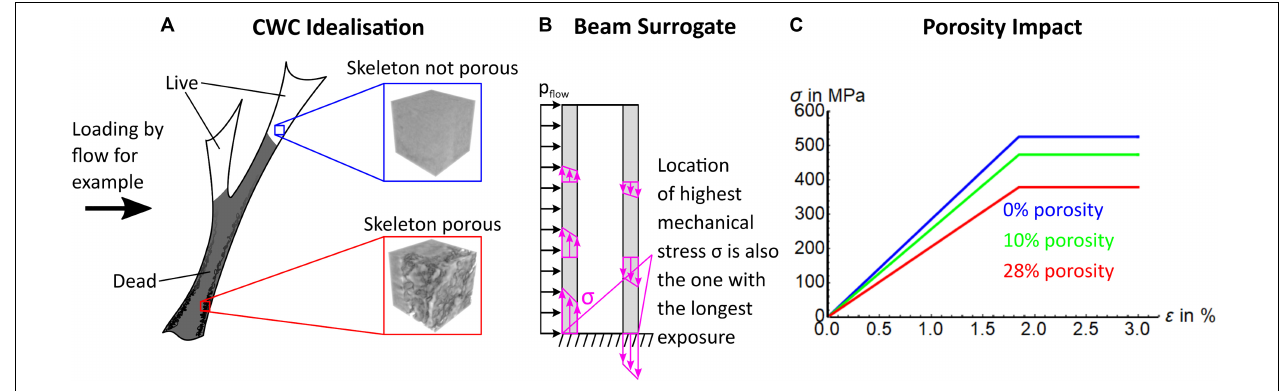
FIGURE 3 | Modelling of coral structural integrity. (A) An idealised representation of a CWC coral with live and dead fractions, with inlays indicating expected occurrences of porosity. (B) Represents a coral as a hollow beam with force applied from one direction (e.g., water flow, p flow ). This beam surrogate, loaded with force perpendicular to the long axis illustrates that the highest stress due to bending occurs at the outer walls (purple arrows, with length representing extent of stress). (C) Theoretical stress ( σ ) vs. strain ( ε ) curves of maximum bearable mechanical stress of a representative volume of an CWC skeleton (blue and red box in A ) is reduced by increasing porosity. Note, yield strain stays the same as we assumed the same impact of porosity on yield strength and stiffness. This is a simplification for illustrational